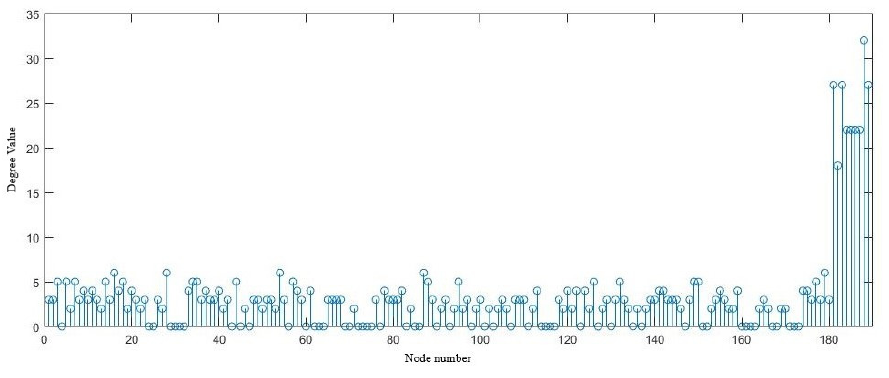
Figure 8. Node degree value.